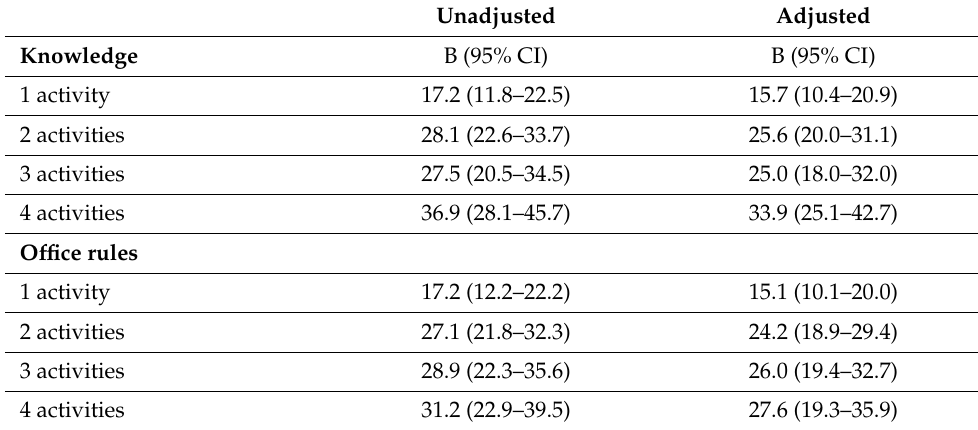
Table 3. Dose—response effects of participation in 1–4 activities on satisfaction with knowledge, office rules, information and support. Estimates (B) indicate the difference from non-participants ( n =